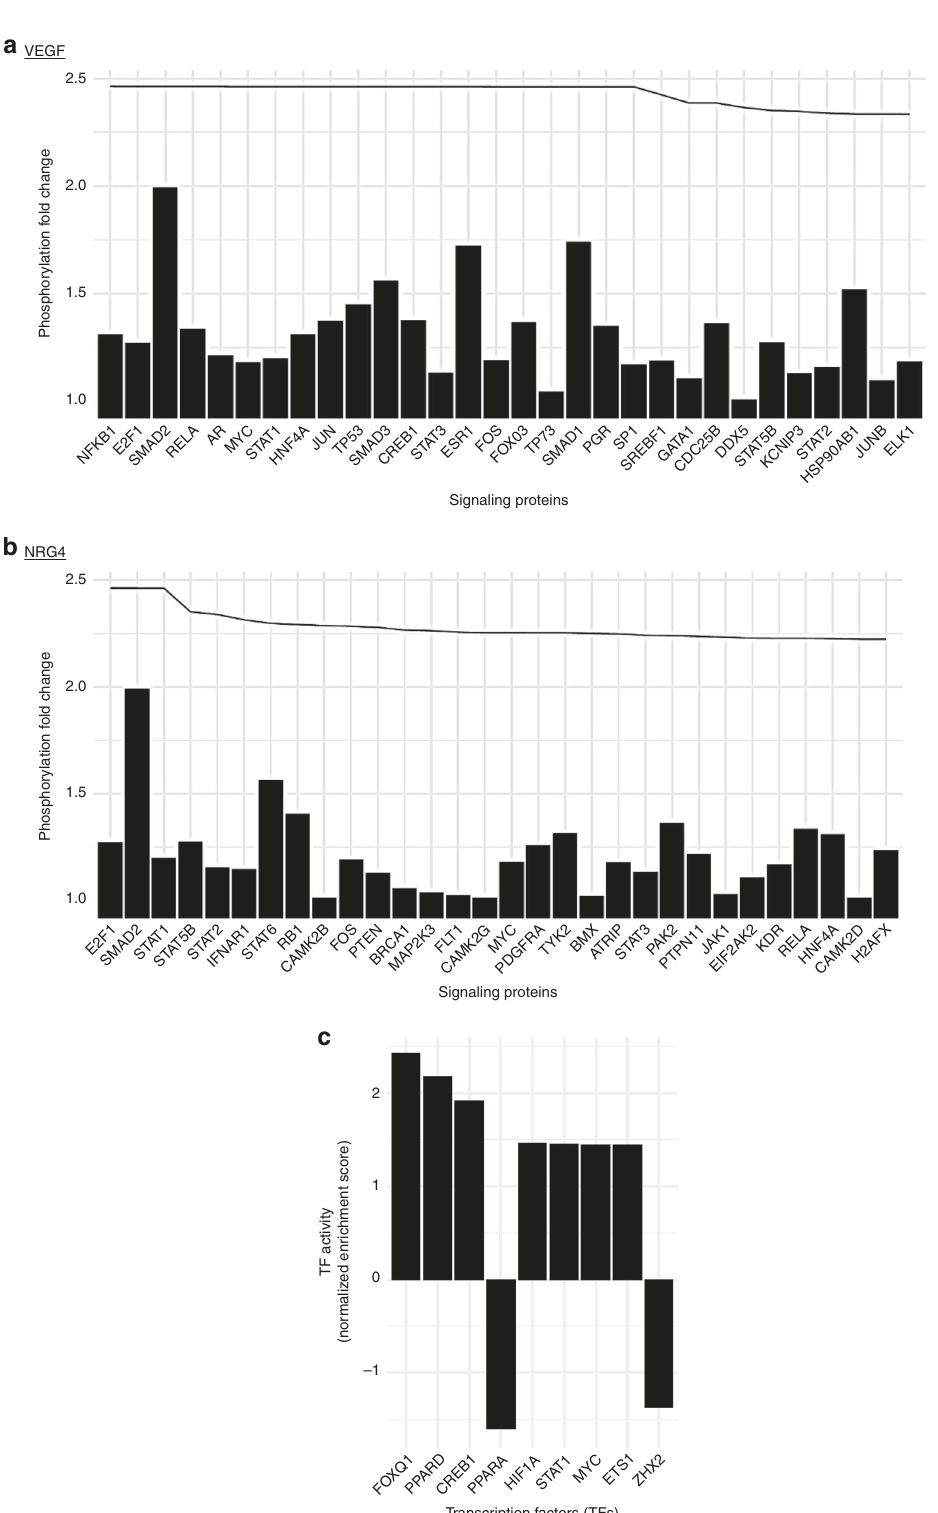
Fig. 8 BMP8b-dependent signaling proteins involved in vegfa and nrg4 regulation. a , b BMP8-induced phosphorylation state fold change of signaling proteins ordered by network distance to the transcription factors regulating vegfa ( a ) and nrg4 ( b ). Bars show the fold changes of the most affected phosphorylation site on each protein, 1 corresponding to no change while, for example, 2 meaning the proportion of phosphorylate proteins doubled upon BMP8 treatment. The top line shows the log scale proximity of the signaling proteins to the transcription factors, from the closest on the left, distance increases to the right. c Estimated activities of transcription factors regulating vegfa in BAT from 5-week-old bmp8b TG mice estimated from expression data. Positive and negative values correspond to up-regulated and down-regulated TFs, respectively. Ordered by p value from the lowest on the left, showing only p value <